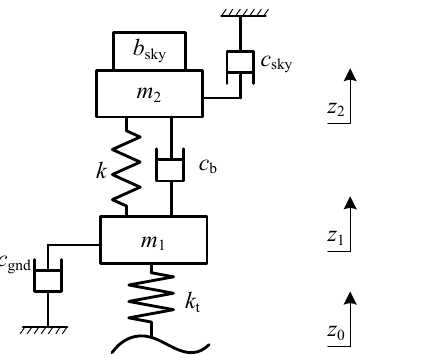
Figure 2. The equivalent system of the multi-hook suspension